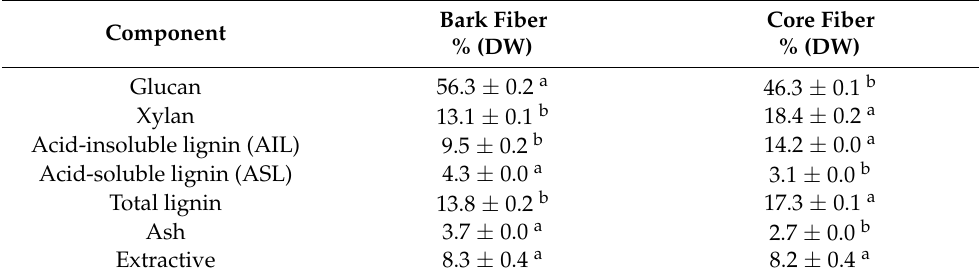
Table 1. Composition of kenaf raw